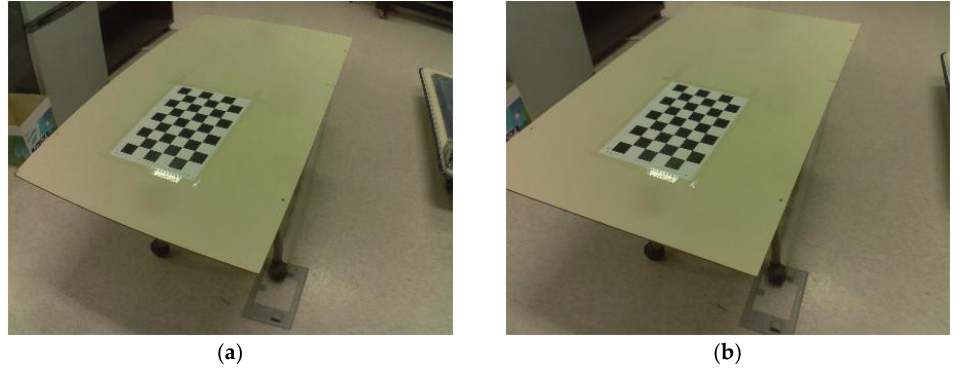
Figure 5. Illustrative example for the image calibration algorithm: ( a ) image distortion resulted from wide-angle lens; and ( b ) image undistortion using image calibration.